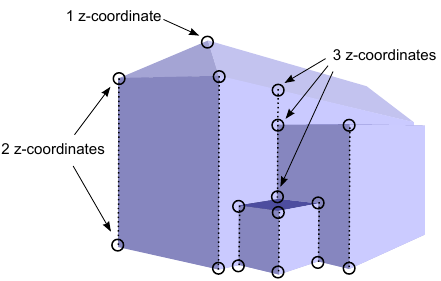
Figure 2. 2D Illustration of the Dual Contouring principle. The input is segmented point cloud (a) and the QEF solutions are the polygonal boundary lines (d).